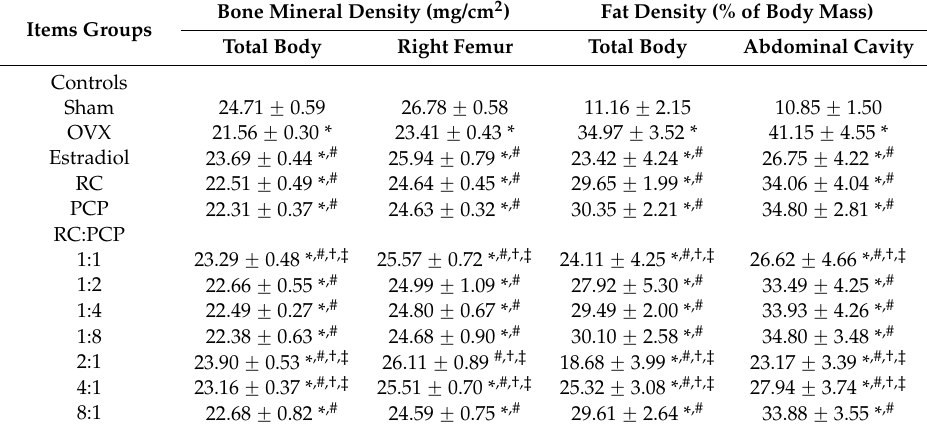
Table 10. Bone mineral density and body fat density in sham-operated or OVX ddY mice.